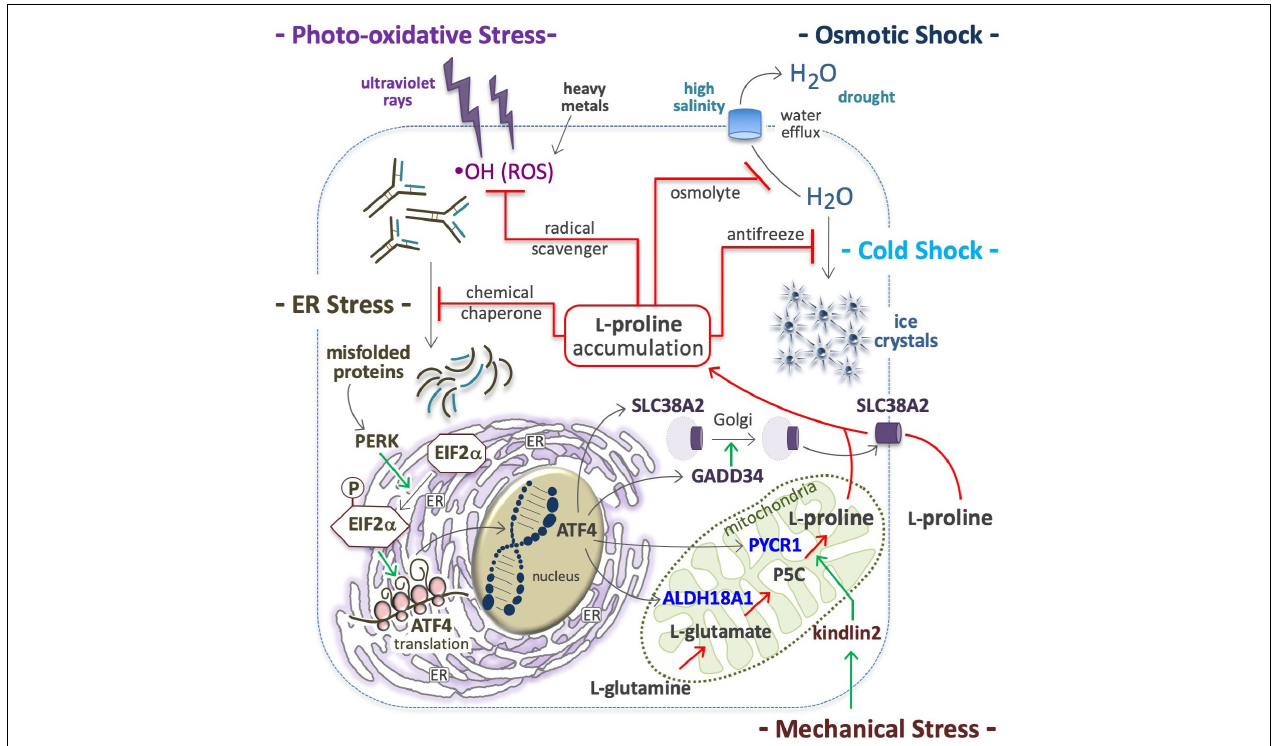
FIGURE 4 | Proline in anti-stress response. Proline accumulation is an evolutionary conserved cell defense mechanism against stressful environments; by quenching hydroxyl radicals ( · OH), protects the cells from ROS oxidations ( top left ) ; as osmolyte avoids high salinity-mediated cell shrinkage ( top right ) , as well as the formation of ice crystal, and thus protects many organisms (yeast, plants, overwinter insect) from cell disruption by freezing ( middle right ) . As a chemical chaperone avoids protein denaturation and thus the accumulation of misfolded proteins ( middle left ) , which are potent inducers of a molecular response that involves the protein kinase R-like endoplasmic reticulum kinase (PERK), phosphorylation of eukaryotic initiation factor 2 (EIF2), and eventually, the translation of activating transcription factor 4 (ATF4) ( bottom left ) ; ATF4 in turn, induces the expression of solute carrier family 38 member 2 (SLC38A2), growth arrest and DNA damage-inducible protein (GADD34), aldehyde dehydrogenase 18 family member a1 (ALDH18A1) and pyrroline-5-carboxylate reductase 1 (PYCR1) ( bottom right ) . Intracellular proline accumulation through proline uptake and de novo proline biosynthesis ( center ) can contribute to stress